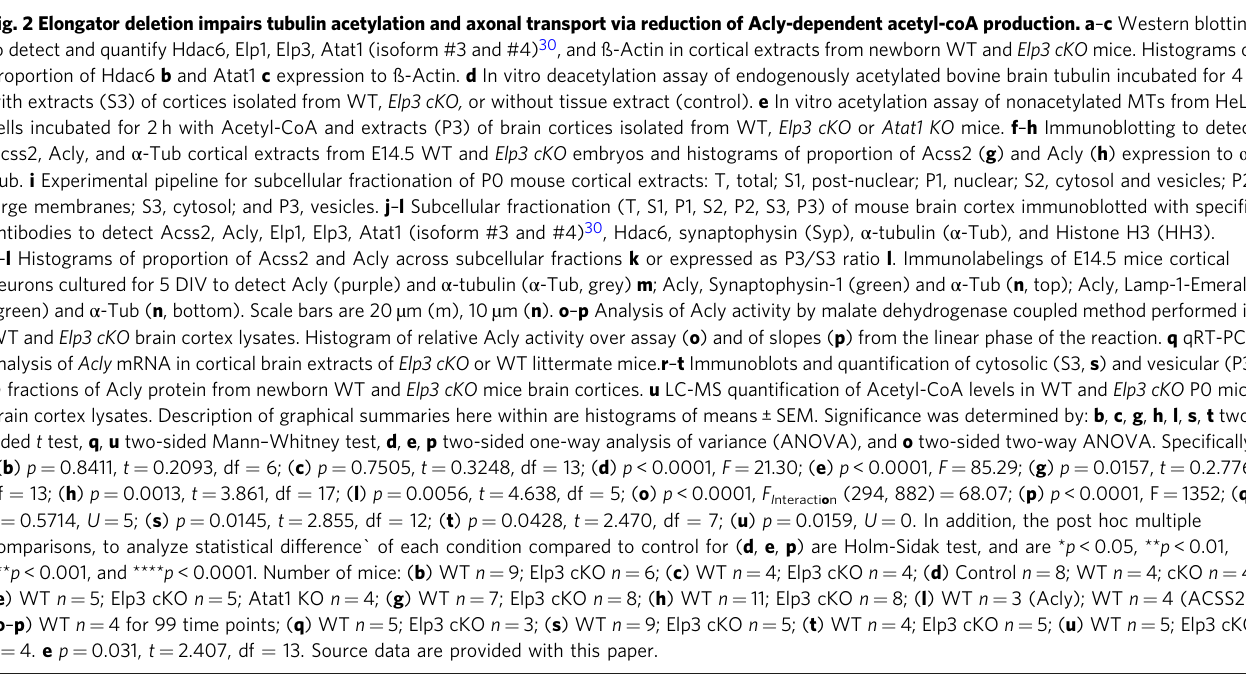
Fig. 2 Elongator deletion impairs tubulin acetylation and axonal transport via reduction of Acly-dependent acetyl-coA production. a – c Western blotting to detect and quantify Hdac6, Elp1, Elp3, Atat1 (isoform #3 and #4) 30 , and ß-Actin in cortical extracts from newborn WT and Elp3 cKO mice. Histograms of proportion of Hdac6 b and Atat1 c expression to ß-Actin. d In vitro deacetylation assay of endogenously acetylated bovine brain tubulin incubated for 4 h with extracts (S3) of cortices isolated from WT, Elp3 cKO, or without tissue extract (control). e In vitro acetylation assay of nonacetylated MTs from HeLa cells incubated for 2 h with Acetyl-CoA and extracts (P3) of brain cortices isolated from WT, Elp3 cKO or Atat1 KO mice. f – h Immunoblotting to detect Acss2, Acly, and α -Tub cortical extracts from E14.5 WT and Elp3 cKO embryos and histograms of proportion of Acss2 ( g ) and Acly ( h ) expression to α - Tub. i Experimental pipeline for subcellular fractionation of P0 mouse cortical extracts: T, total; S1, post-nuclear; P1, nuclear; S2, cytosol and vesicles; P2, large membranes; S3, cytosol; and P3, vesicles. j – l Subcellular fractionation (T, S1, P1, S2, P2, S3, P3) of mouse brain cortex immunoblotted with speci fi c antibodies to detect Acss2, Acly, Elp1, Elp3, Atat1 (isoform #3 and #4) 30 , Hdac6, synaptophysin (Syp), α -tubulin ( α -Tub), and Histone H3 (HH3). k – l Histograms of proportion of Acss2 and Acly across subcellular fractions k or expressed as P3/S3 ratio l . Immunolabelings of E14.5 mice cortical neurons cultured for 5 DIV to detect Acly (purple) and α -tubulin ( α -Tub, grey) m ; Acly, Synaptophysin-1 (green) and α -Tub ( n , top); Acly, Lamp-1-Emerald (green) and α -Tub ( n , bottom). Scale bars are 20 µ m (m), 10 µ m ( n ). o – p Analysis of Acly activity by malate dehydrogenase coupled method performed in WT and Elp3 cKO brain cortex lysates. Histogram of relative Acly activity over assay ( o ) and of slopes ( p ) from the linear phase of the reaction. q qRT-PCR analysis of Acly mRNA in cortical brain extracts of Elp3 cKO or WT littermate mice. r – t Immunoblots and quanti fi cation of cytosolic (S3, s ) and vesicular